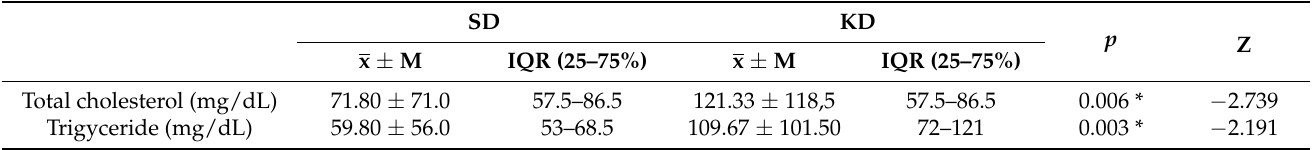
Table 4. Maternal total cholesterol and triglyceride levels at GD20.